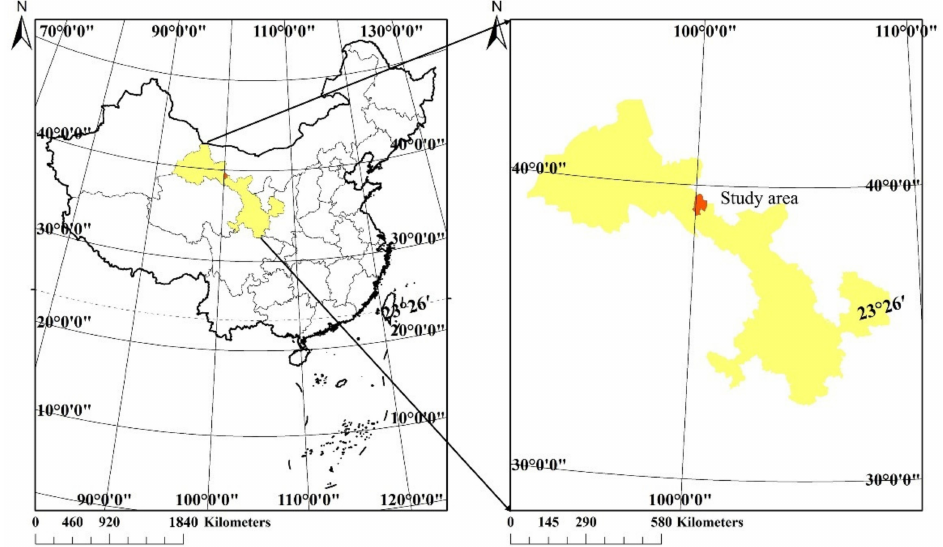
Figure 1. Study area and location (Linze of Gansu Province).